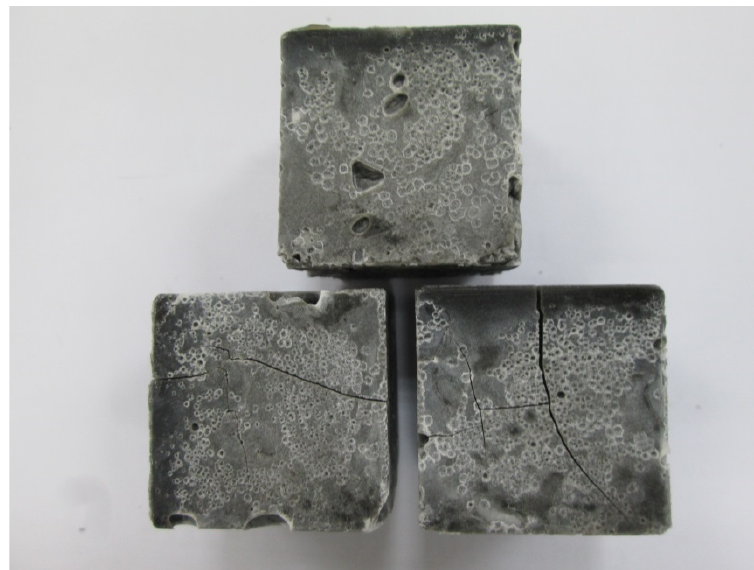
Figure 8. Thermal cracking in geopolymer specimens caused by overcuring.